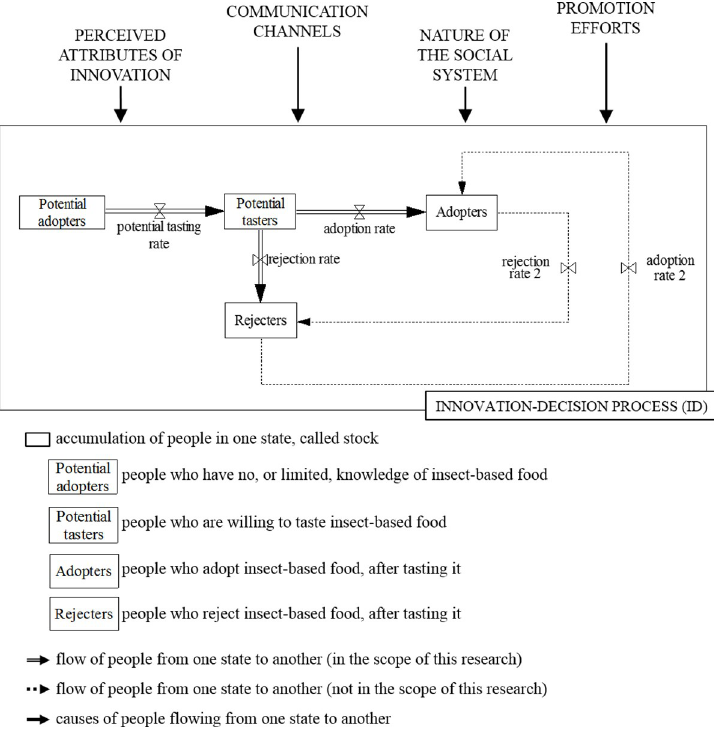
Fig 1. Framework to analyse insect-based food adoption literature and to build the model, based on the diffusion of innovations paradigm [33] and the Bass diffusion system dynamics model [16].